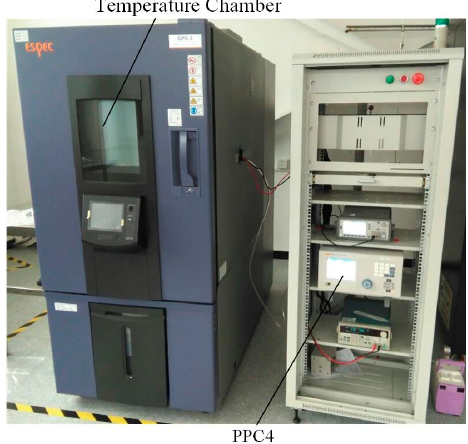
Figure 12. The calibration system for the sensor.